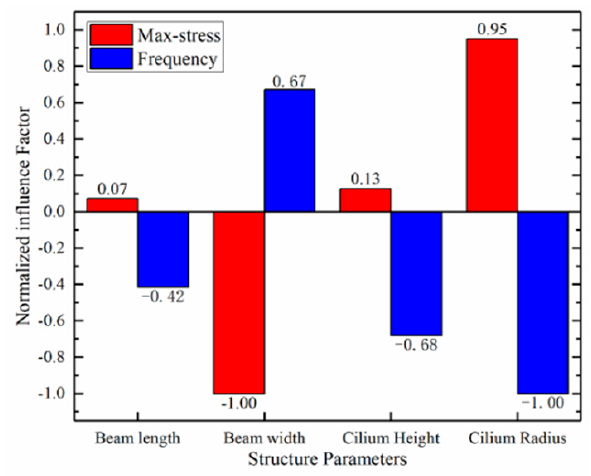
Maximum stress variation is negatively correlated with beam width but positively correlated with beam length, cilium radius, and cilium height. The maximum stress variation on the beam is proportional to the sensitivity, so the hydrophone’s sensitivity conflicts with the natural frequency. By analyzing the relationship between natural frequency and the maximum stress variation on the beam, the influencing factors of structure parameters were obtained, as is shown in Figure 10.